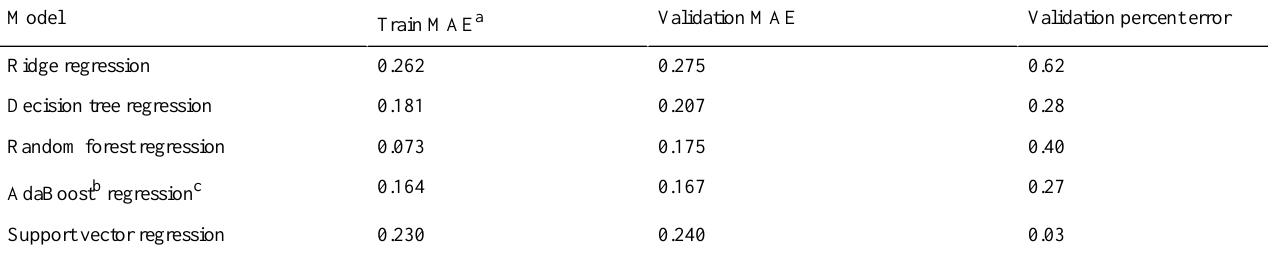
Table 7. Optimal MAE and median percent error values for the cross-validation method. Validation error is equivalent to test error for